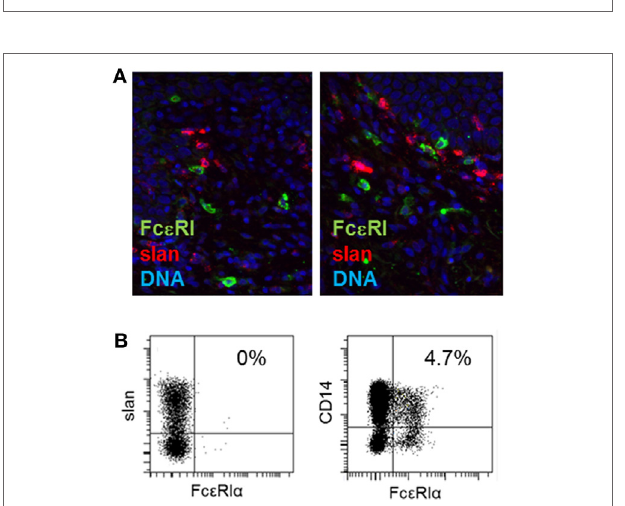
FigUre 2 | Expression of Fc ε RI by 6-sulfo LacNAc-expressing monocytes (slanMo) in skin and blood. (a) Immunofluorescent staining of slan (red) and Fc ε RI (green) in normal human skin (left) or skin from atopic dermatitis patients (right). Cell nuclei were stained with DAPI (blue). Representative results of 10 donors analyzed are shown. (B) Blood slanMo and CD14 + monocytes from patients with atopic dermatitis were analyzed for the expression of Fc ε RI by flow cytometry. A Representative result of 14 donors is shown.